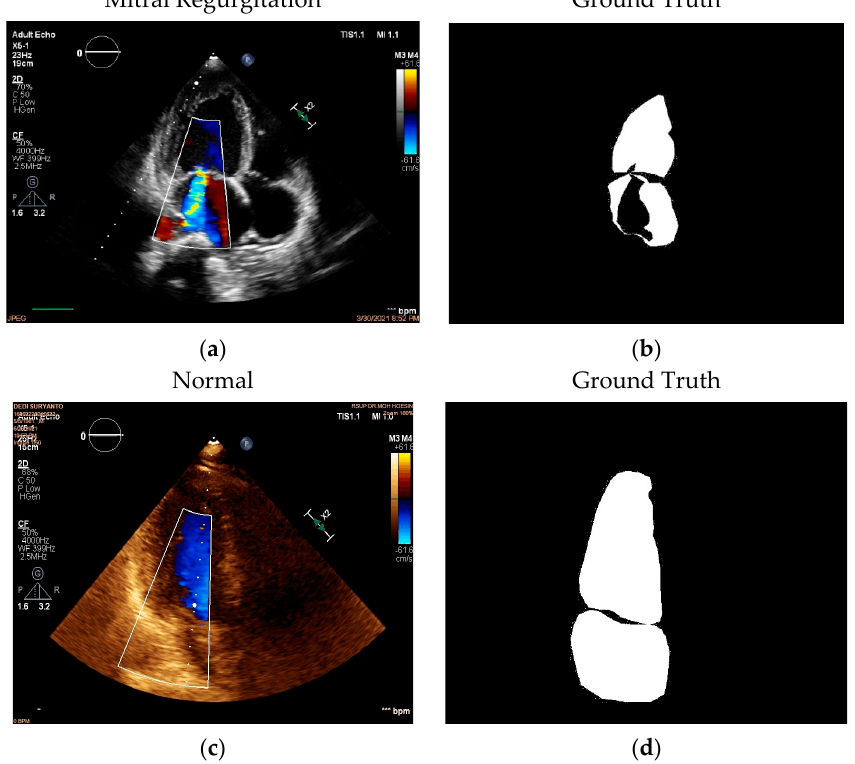
Figure 2. ( a ) original image; ( b ) Ground Truth; ( c ) normal; ( d ) Ground Truth.